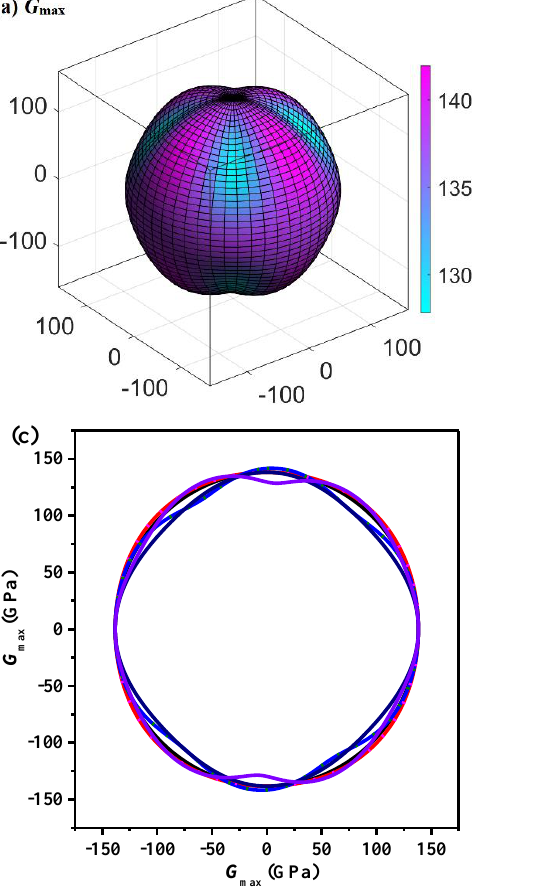
Figure 4. The directional dependence of the maximum values for the shear modulus (in GPa) for P 4/ m BN ( a ), the minimum values for the shear modulus (in GPa) for P 4/ m BN ( b ), the 2D representation of the maximum values for the shear modulus (in GPa) for P 4/ m BN ( c ) and the 2D representation of the minimum values for the shear modulus (in GPa) for P 4/ m BN ( d ).